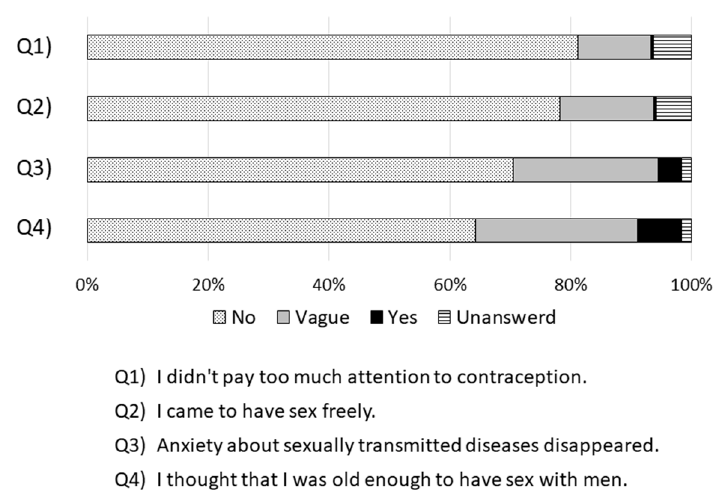
Figure 1. Change in awareness of sexual activity after HPV vaccination.